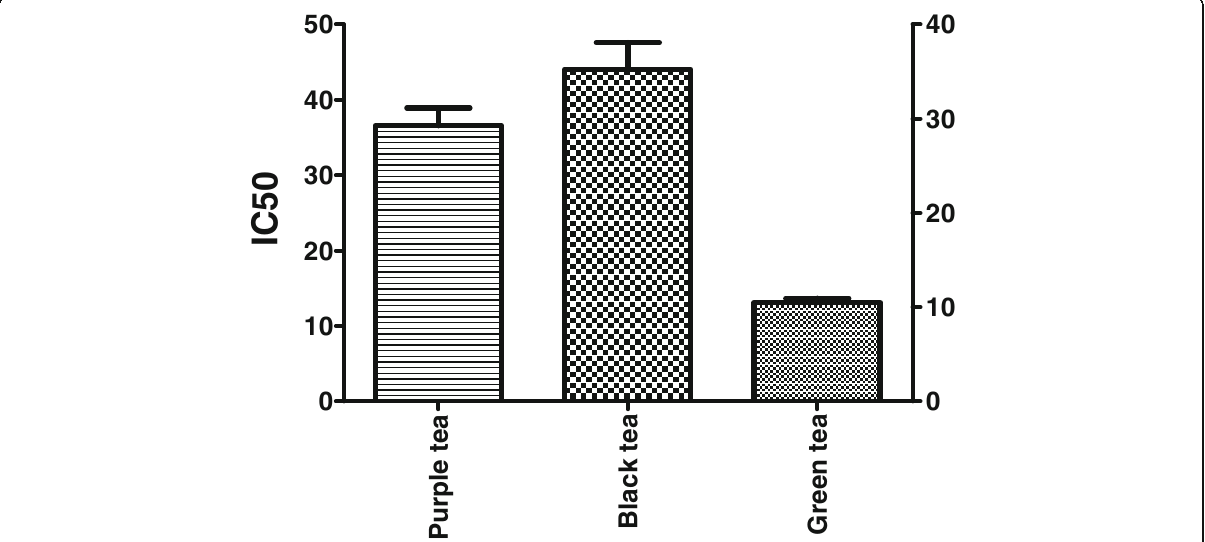
Fig. 1 Quantification of the inhibitory concentration (IC 50 μ g/ml) of purple, black and green teas on 4TI cancer